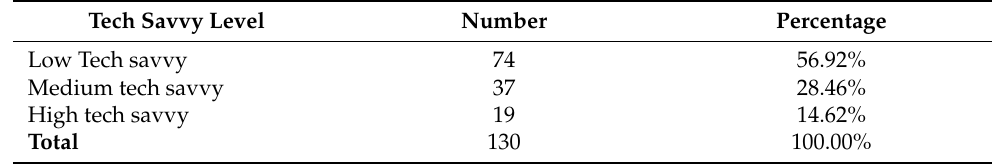
Table 4. Technological savvy levels of womenpreneurs.